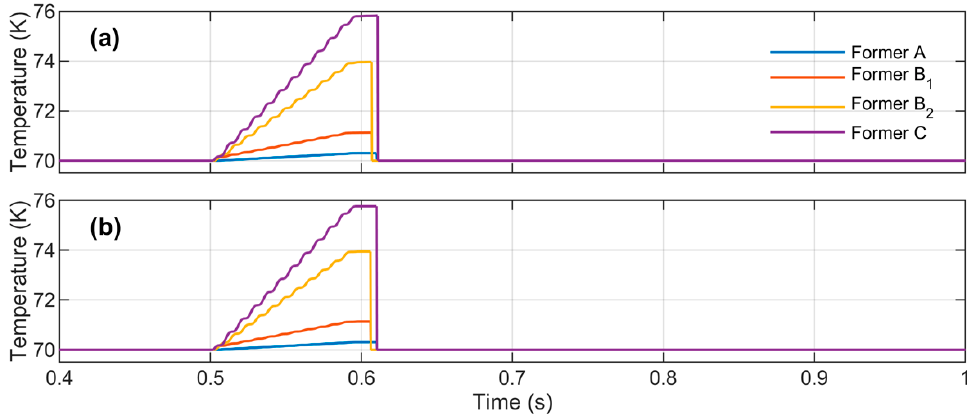
Figure 15. HTS cable temperatures in case DCRs operate normally: ( a ) HTS 1 ; ( b ) HTS 2 .